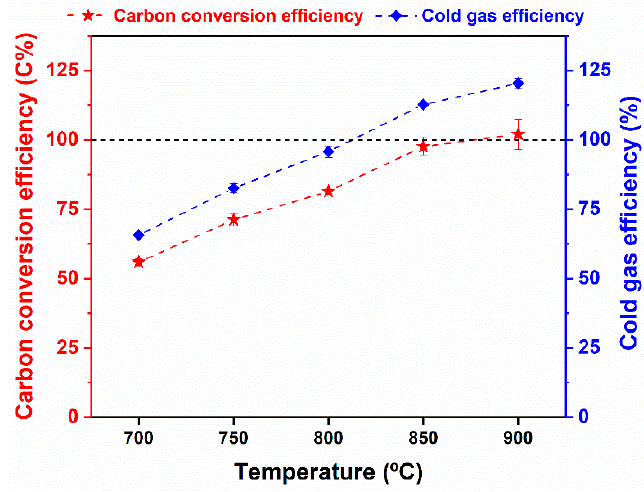
Figure 6. The carbon conversion efficiency and cold gas efficiency from steam gasification of raw WS as a function of gasification temperature.